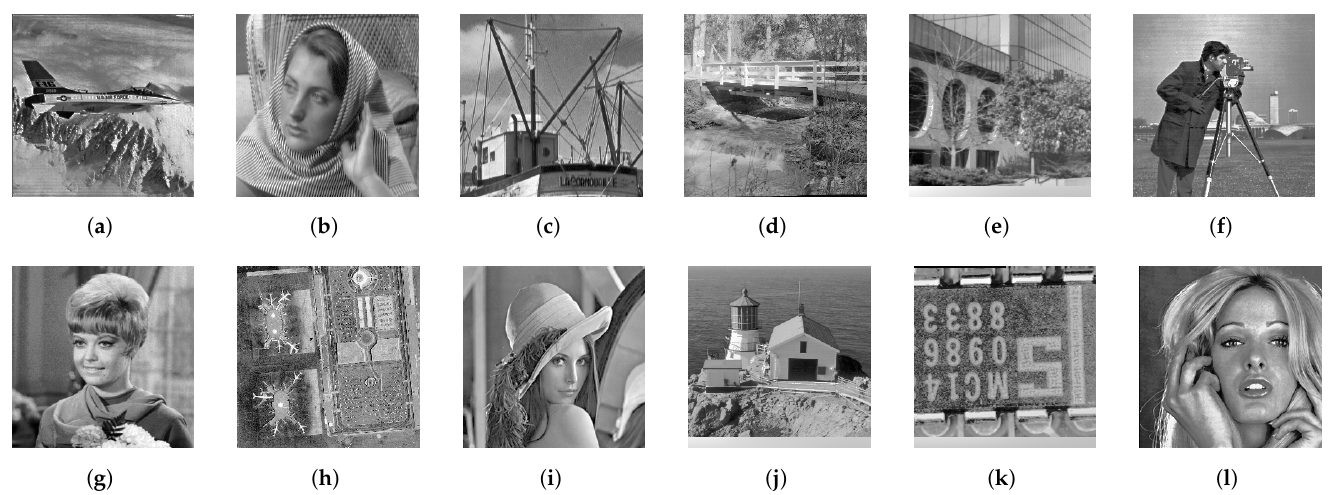
Figure 18. The proposed exact histogram specification: ( a ) Airplane, ( b ) Barbara, ( c ) Boat, ( d ) Bridge, ( e ) Building, ( f ) Cameraman, ( g ) Girl, ( h ) Lax, ( i ) Lenna, ( j ) Lighthouse, ( k ) Text, ( l )